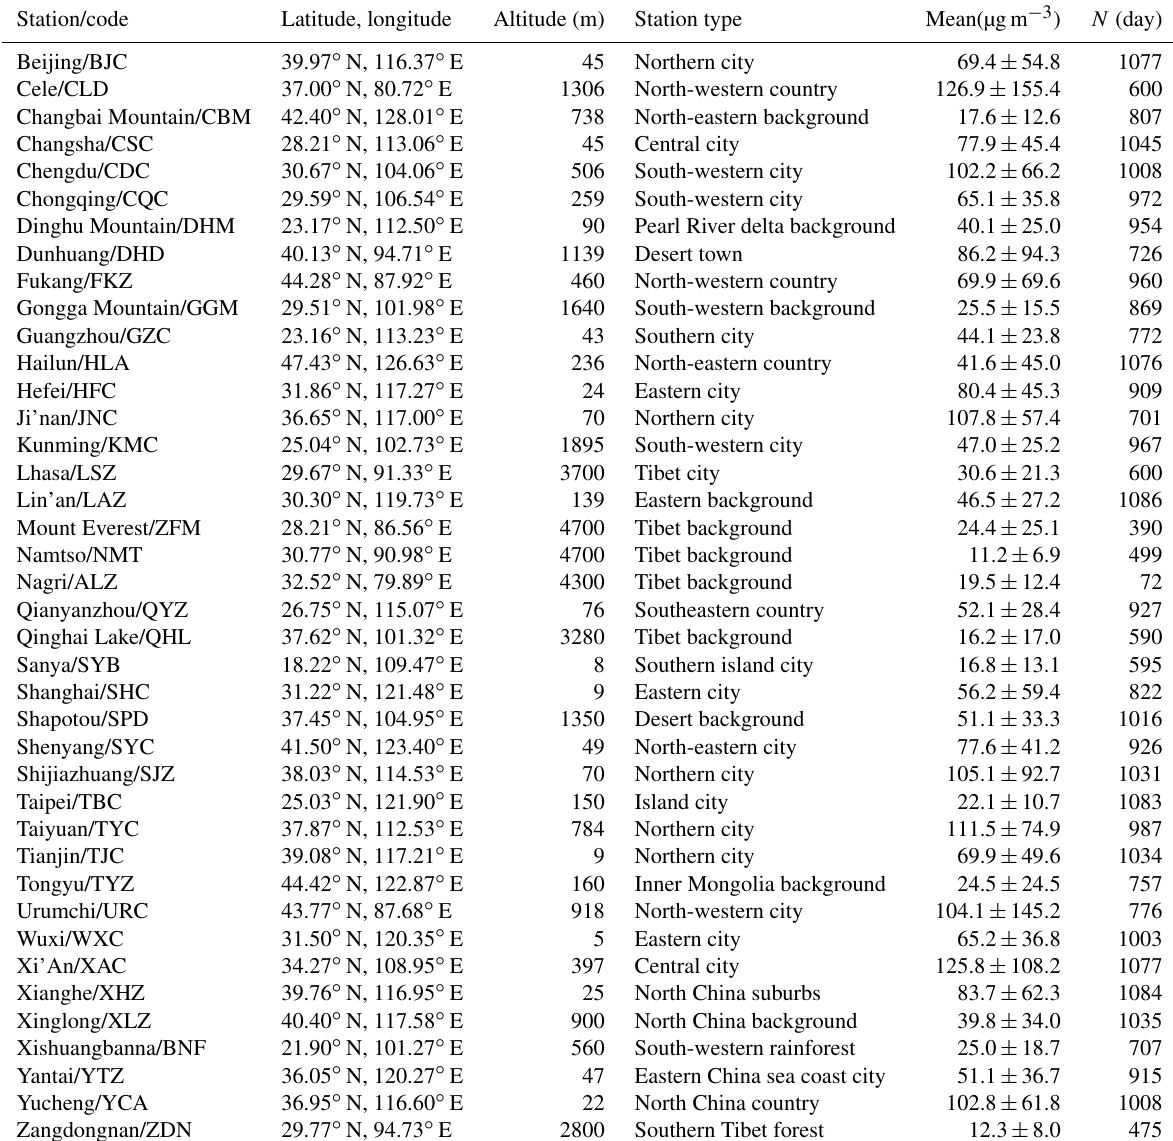
Table 1. Geographic information and 3-year mean PM 2 . 5 concentration of the monitoring stations.